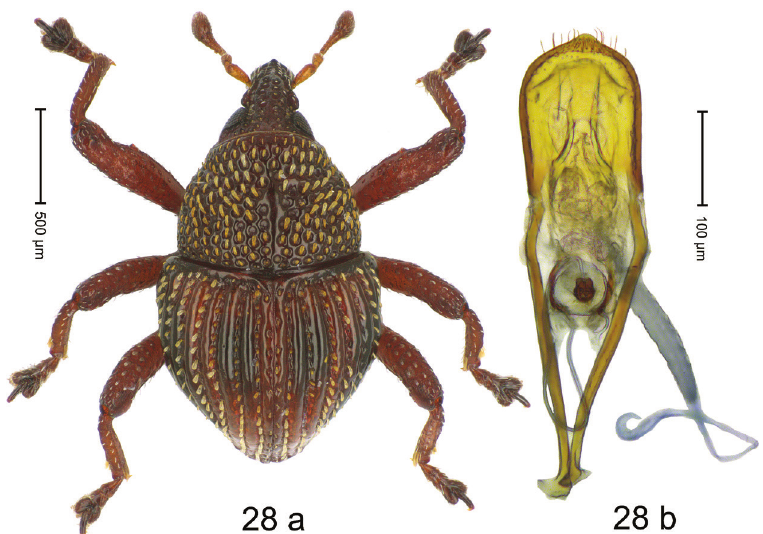
Figure 28. Trigonopterus unyil sp. nov., holotype a habitus b penis.